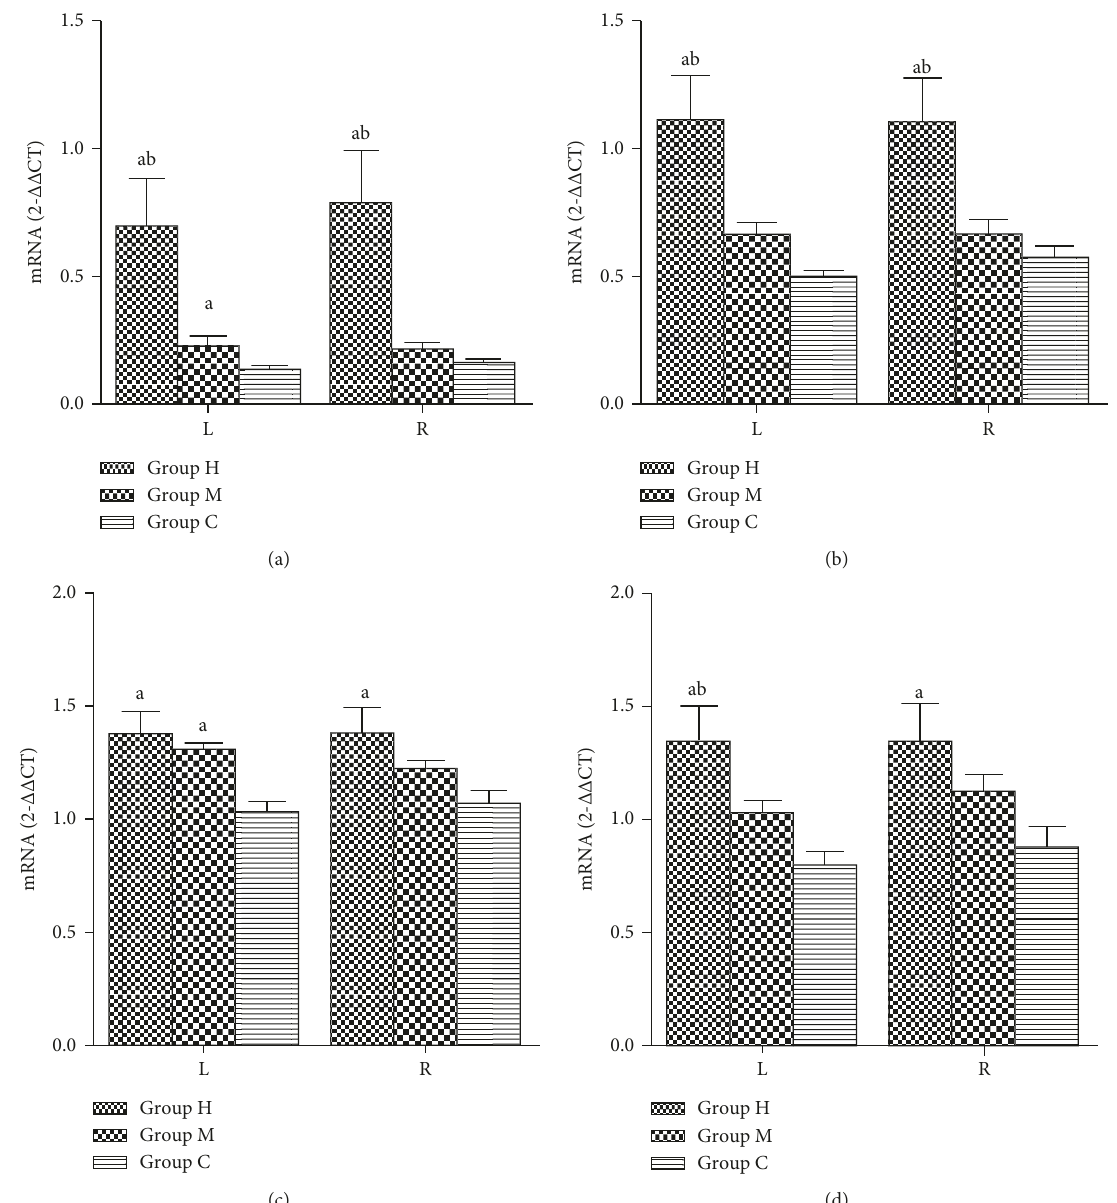
Figure 7: (a–d) Effects of different-intensity exercise training on Kir2.1, Kir2.2, Kir3.1, and Kir3.4 mRNA expression of left and right atria in rabbits. Compared with Group C, a P